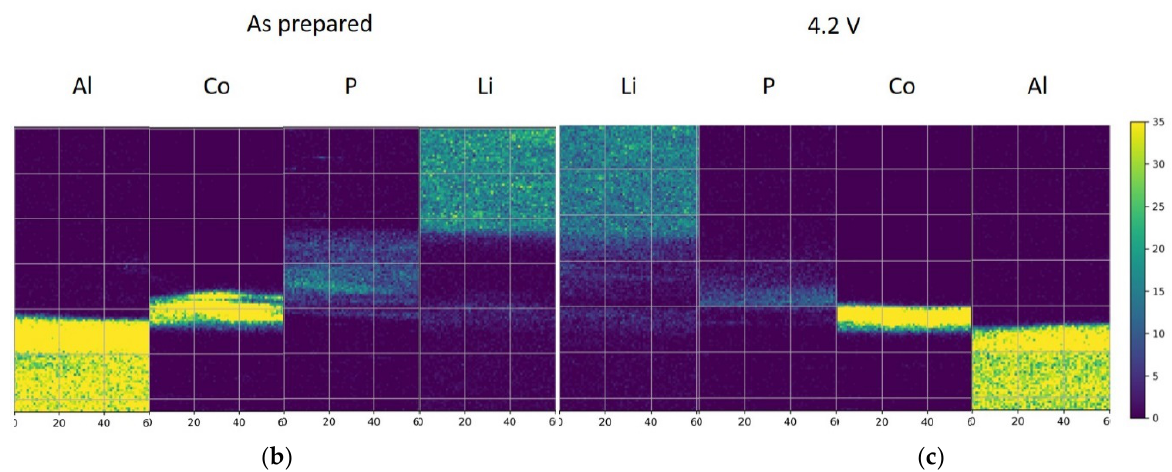
Figure 6. ( a ) Li and Co profiles of the operando cell. The LCO + MEEP layer lies at the right, a MEEP separator in the center, and the lithium metal on the left side. The LCO layer slightly changes its width and position upon charging with 4.2 V with a lithium concentration increase around pixel 65. ( b ) Elemental map before (asprep) and ( c ) after charging at 60 °C and 4.2 V. Li clearly migrated from the separator side of the LCO towards the Li metal. The scale bar is the same for all and represents the counts per pixel.